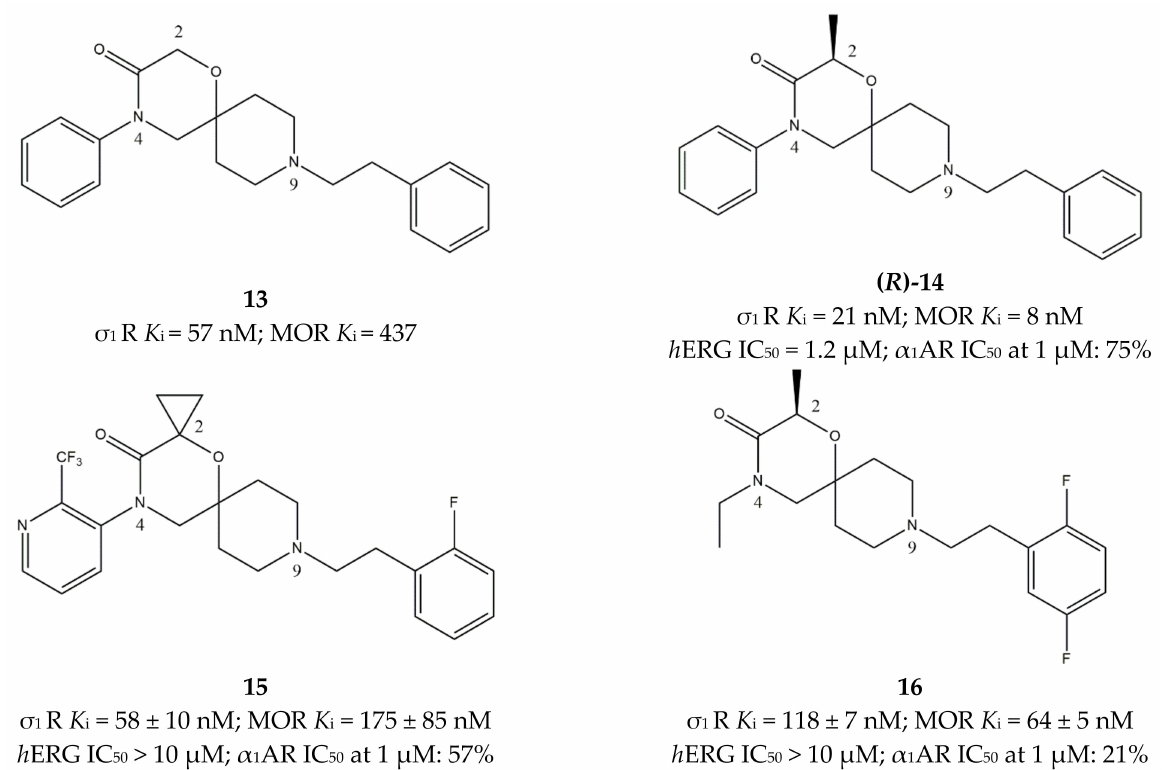
Figure 13. Compounds ( 13 – 16 ) and their K i and IC 50 values for σ 1 ( σ 1 R), µ -opioid (MOR) and alpha-1 adrenergic ( α 1 AR) receptors and human ether-a-go-go-related gene channel ( h ERG)